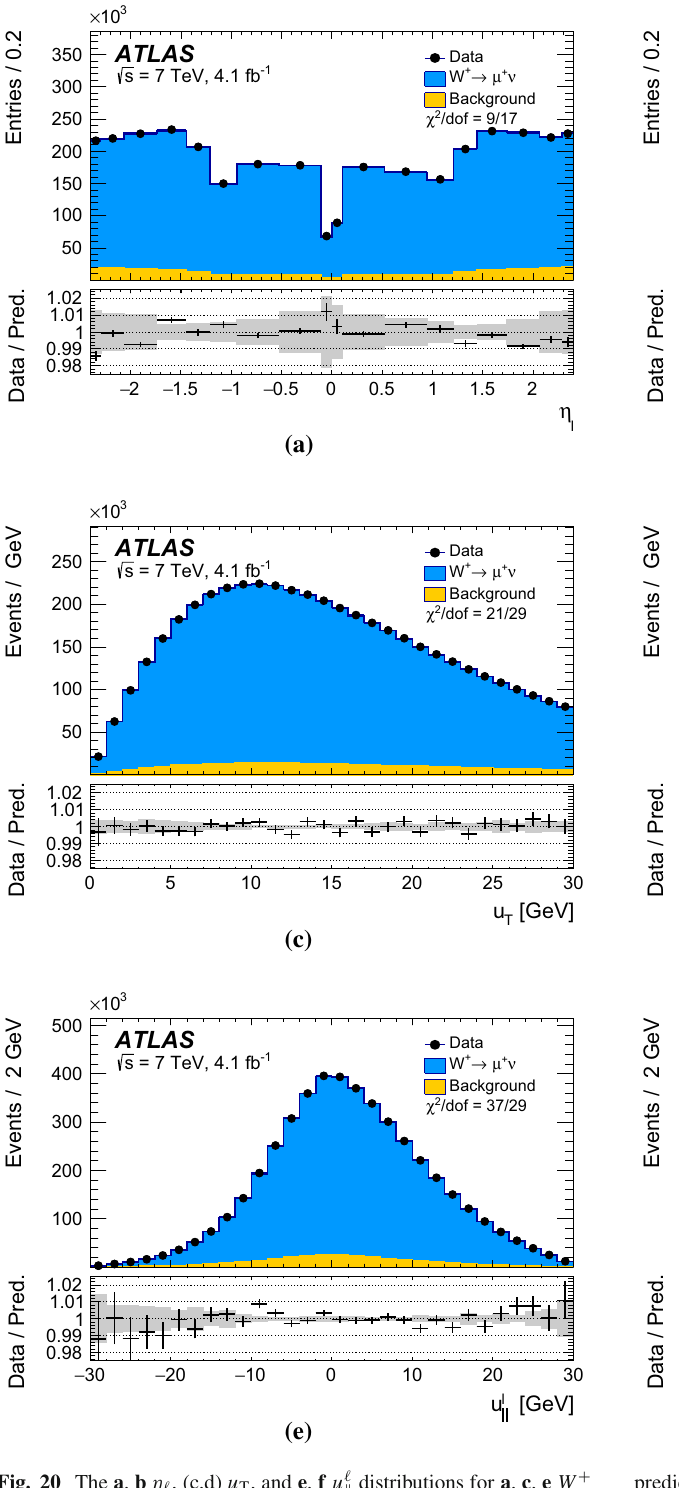
prediction ratios, the error bars show the statistical uncertainty, and the band shows the systematic uncertainty of the prediction. The χ 2 val- ues displayed in each figure account for all sources of uncertainty and include the effects of bin-to-bin correlations induced by the